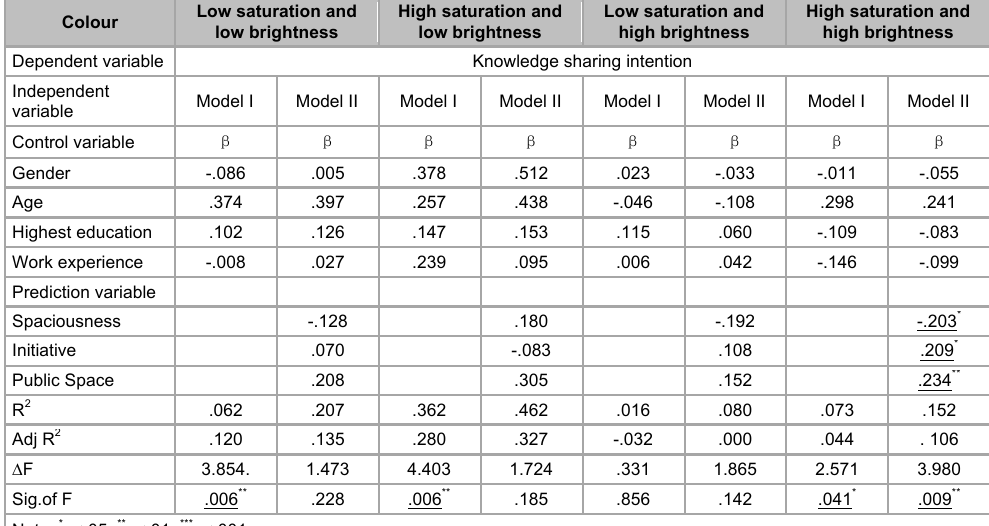
Regression analysis of the moderating effects of Colour on the relations between Office Space and Knowledge